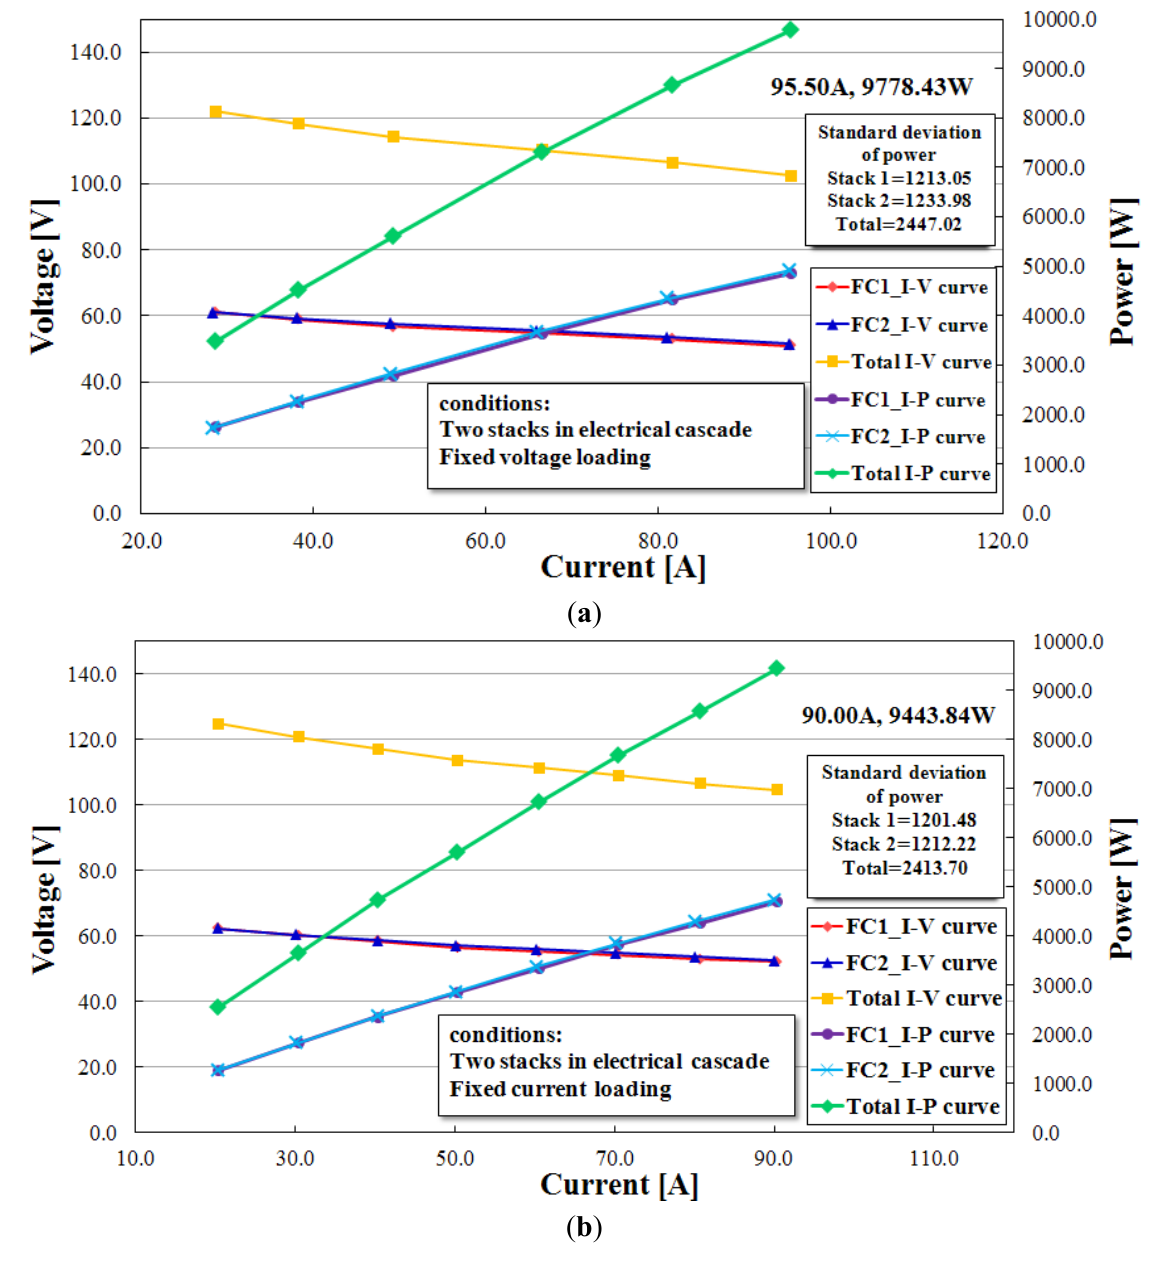
Figure 6. The I - V and I - P curves of each stack in electrical cascade: ( a ) fixed voltage loading; and ( b ) fixed current